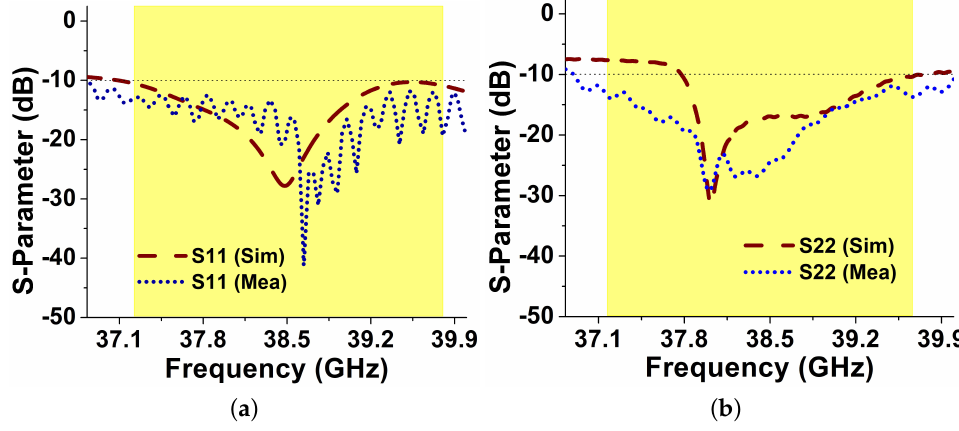
Figure 7. Reflection coefficient of 4-port MIMO antenna with respect to ( a ) P1; and ( b ) P2.